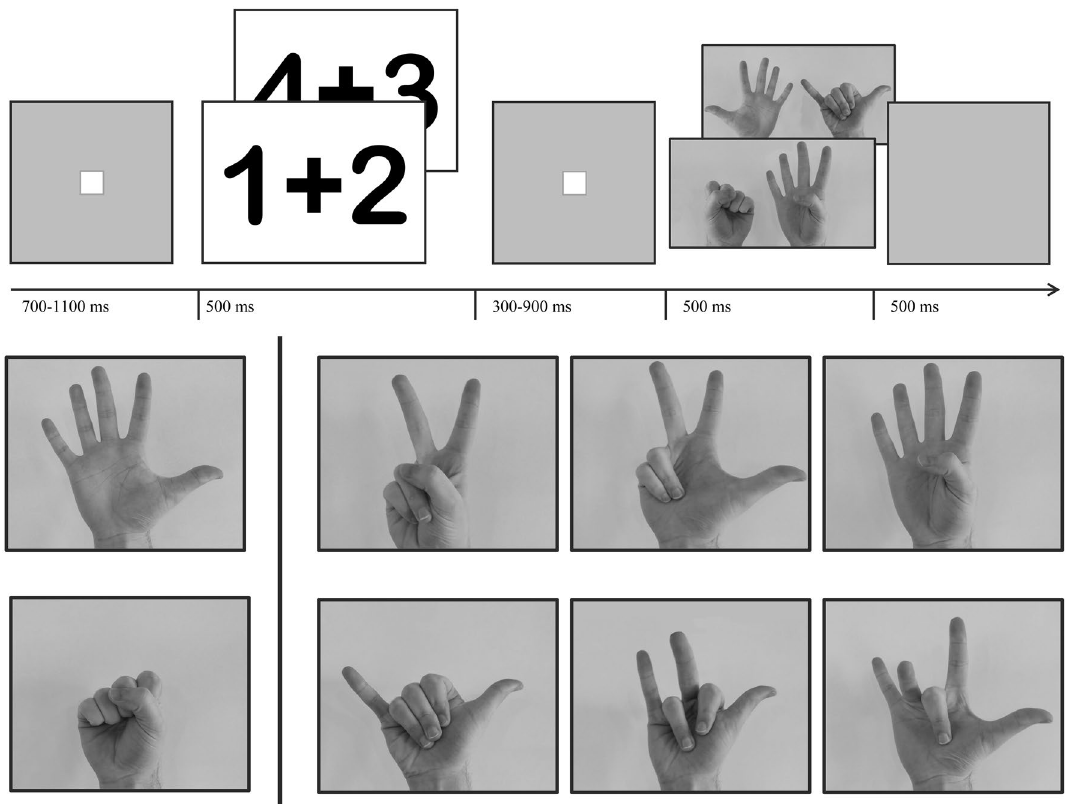
Figure 5. The Math Task (top) showing two examples of addition problems presented in Arabic Numerals, followed by a variable interval (between 300 and 900 ms), followed by a problem solution presented by the hands (foreground: incorrect problem solution represented by a canonical finger configuration; background: correct problem solution represented by a non-canonical finger representation). The montring finger stimuli (bottom) were composed of canonical (top row) or non-canonical (bottom row) patterns combined with an open (top row left) or closed hand (bottom row left). Task stimuli were drawn hands obtained from the internet (see Ref. 49 ), but due to copyright considerations photos of the presented postures are shown in this and one type of hand stimulus (canonical/non-canonical) never shown more than four times in a row. In half of the incorrect trials the number represented by the hands had a distance of 1 from the correct Solution, while the other half had a distance of 2. All stimuli were presented on grey backgrounds inside white boxes at the center of a 19-inch monitor with a viewing distance of 57 cm using the PsychoPy python package 48 . Selection of finger pattern stimuli. The selection of the non-canonical and canonical montring stimuli included in the present study was based on a small pilot questionnaire study with N = 14 students that were presented with a row of four pictures showing different finger patterns representing the same number. Two of the four presented patterns were different non-canonical patterns and the other two were the two possible canonical patterns with adjacently raised fingers but one canonical pattern including the thumb (often called ‘counting’ pattern) and the other canonical pattern without the thumb (often called ‘montring’ pattern). The students were asked to rate the four finger patterns on the likelihood that they would use them to communicate a number to someone else (scale 1–4, with 1 highest likelihood and 4 lowest likelihood). For each of the included numbers 2, 3, and 4, out of the two non-canonical finger patterns we chose the pattern that was rated as most unlikely being used for commu- nicating the number. Of the two canonical patterns we (for each number) chose the canonical pattern that was indicated by the majority as the most likely used way to communicate the number (although both canonical pat- terns did not differ much in rating but both differed strongly in rating from both non-canonical patterns). This resulted in the non-canonical and canonical finger patterns shown in Fig. 5 (note that the same finger patterns for 2, 3 and 4 were used for higher numbers 7, 8, 9, only accompanied by a full-hand indicating 5, whereas in the case of 2, 3, 4 a second hand was also shown but with a closed fist representing zero).